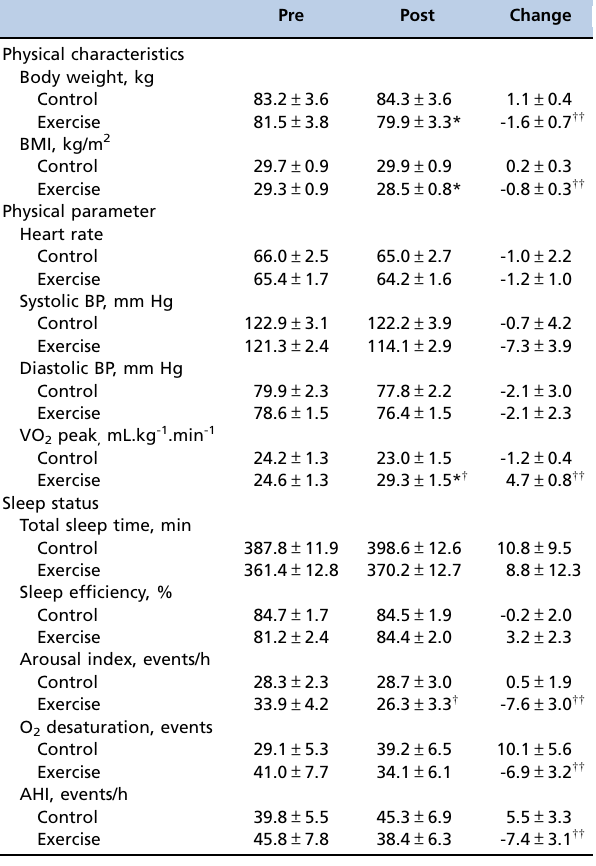
Table 2 - Effects of exercise training on physical characteristics, physical capacity, and sleep parameters in individuals with obstructive sleep apnea.